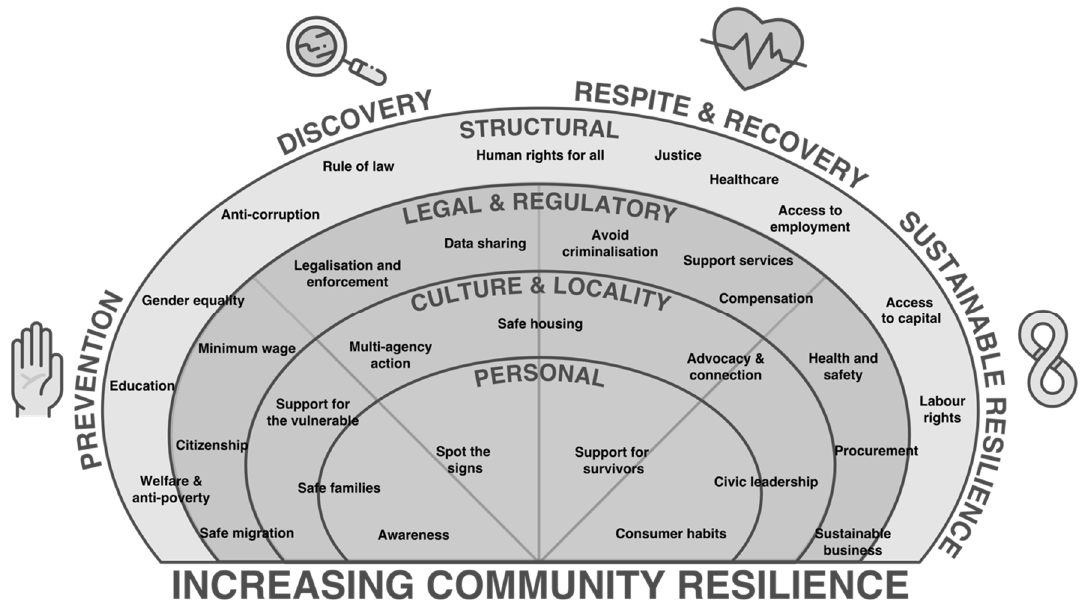
Figure 1. The social determinants of a slavery-free community (originally in Gardner et al. [8]).